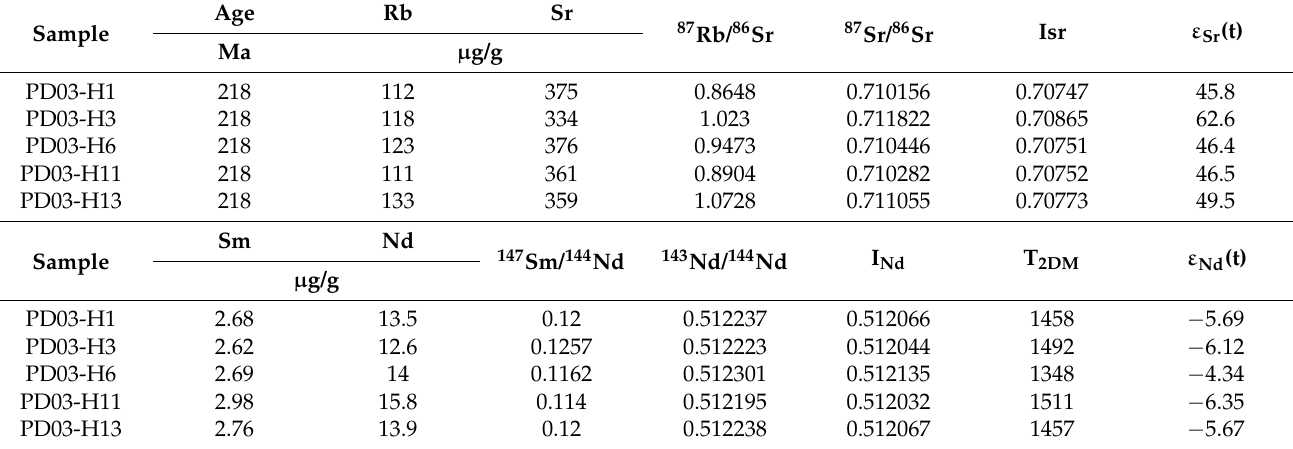
Table 4. Sr–Nd isotopic composition of the Wuzhutang granite in the Xuebaoding mining